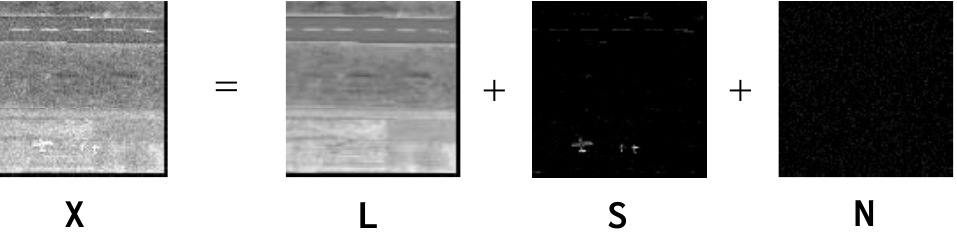
Figure 1. Process of the LRaSMD algorithm. L is the low-rank part corresponding to the background. S is the sparse part corresponding to the target. N stands for the noise